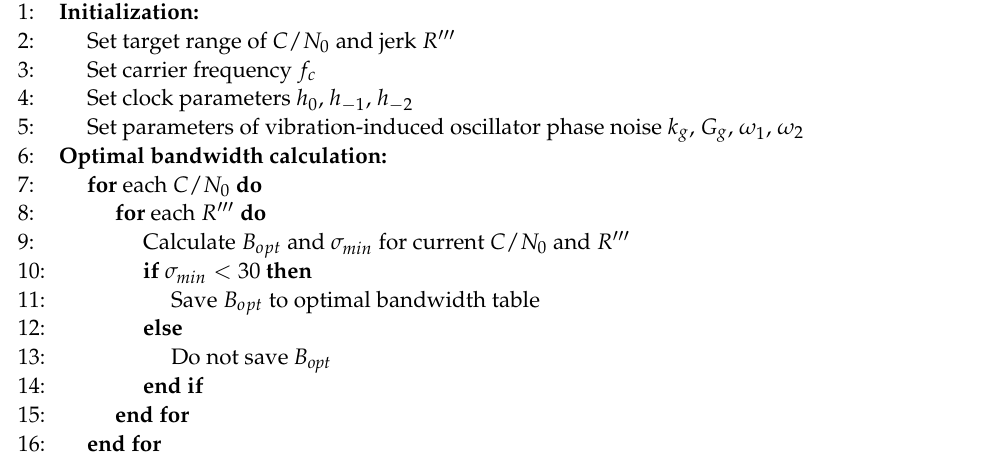
Figure 5. Example of the measurement error calculation results with respect to the noise bandwidth variation for low signal-to-noise ratio (SNR) and high dynamics conditions. Algorithm 1 Optimal bandwidth table generation